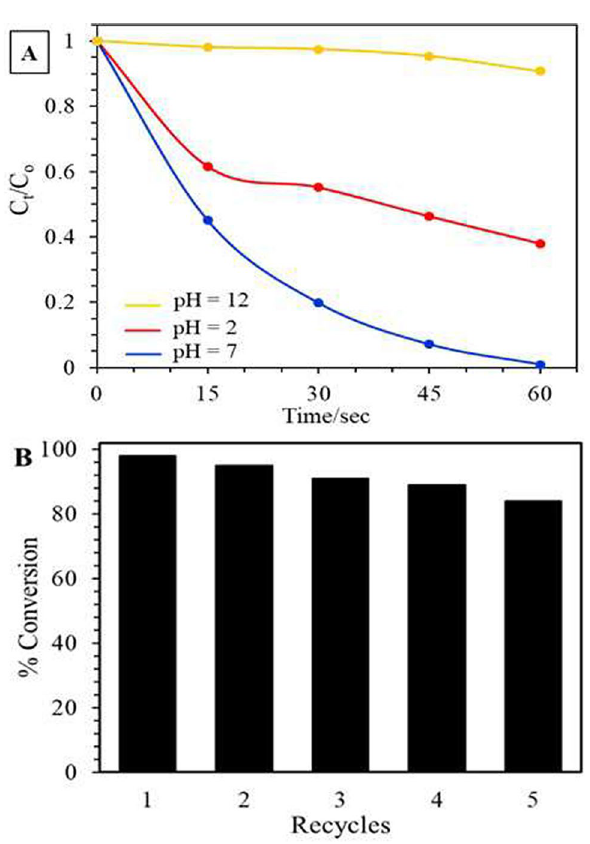
Figure 11. ( A ) The change in the concentration of 4-NP with time in the reduction of 4-NP by Mn 3 O 4 /Ag 2 WO 4 (60%) at different pH and ( B ) Repeated cycles up to 5 times illustrating the reduction of 4-NP over the same photocatalyst. Reaction conditions: 100 mL 4-NP of conc. 0.001 M, NaBH 4 conc. of 0.2 M, 0.1 g